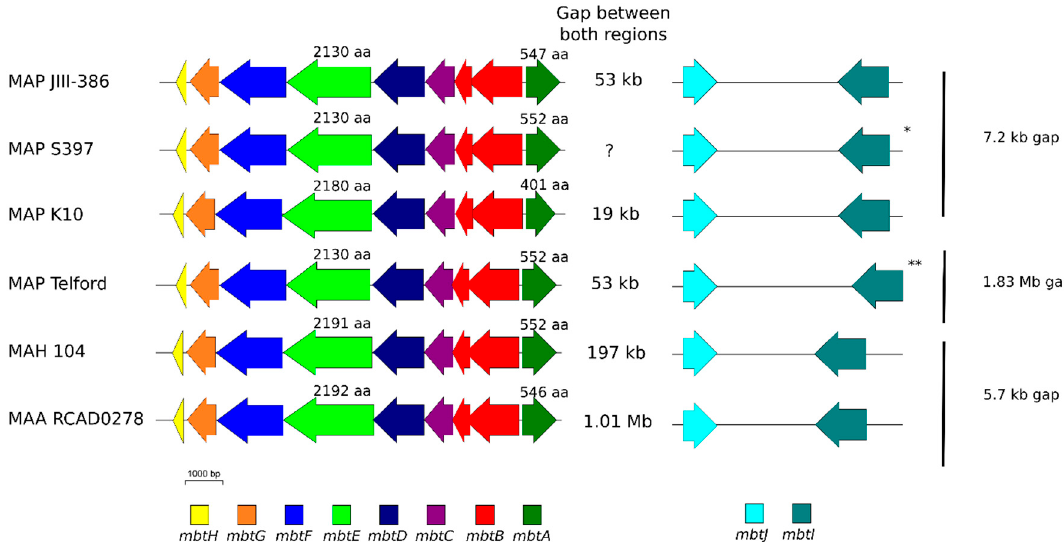
Figure 5. Mycobactin cluster in MAP-S/type III strains JIII-386 and S397, MAP-C strain K-10, MAP-S/type I strain Telford, MAH 104 and MAA RCAD0278. Identical colors matched to identical genes. Gene lengths are shown for mbtA and mbtE because of existing differences. MAP-S strains share a gap of identical size between mbtA and mbtJ genes in contrast to the other strains. * Predicted size of gap between mtbJ and mbtI: genes that are located on different contigs; ** Because of a rearrangement in Telford, mbtJ and mbtI genes are far apart from each other.